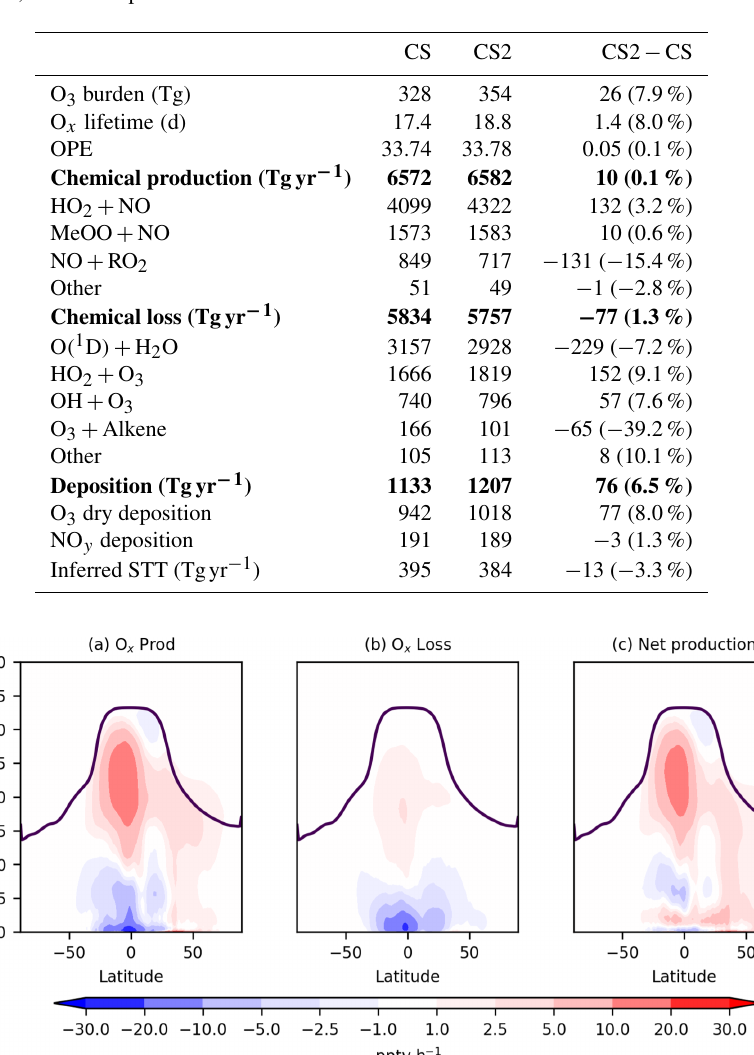
Table 6. Annual mean O x diagnostics for CRI-STRAT and CRI-STRAT 2 and the difference between the mechanisms (percentage changes in parentheses). UKESM1 CMIP6 1995–2004 using ST: chemical production = 5315Tgyr − 1 ; chemical loss = 4476Tgyr − 1 ; dry deposi- tion = 867Tgyr − 1 (Griffiths et al., 2021). Entries in bold show total production, loss and deposition, and entries in plain text show individual components of this production, loss and deposition.